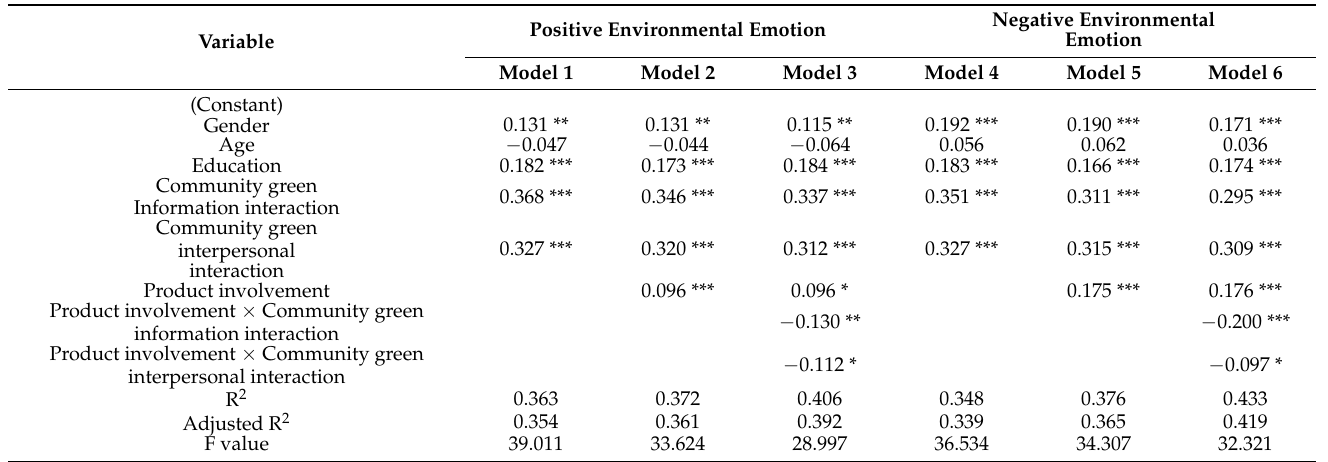
Table 6. Moderating effect of product